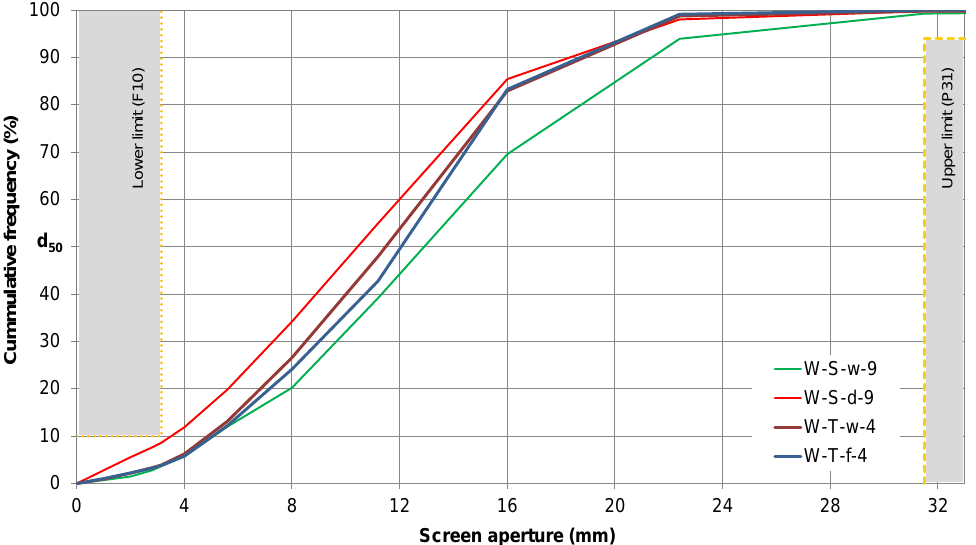
Figure 11. Particle size distribution for fine wood chips from fresh, dried and frozen willows and standard ranges according to EN ISO 17225-1; Labelling of trials: see Table 1.